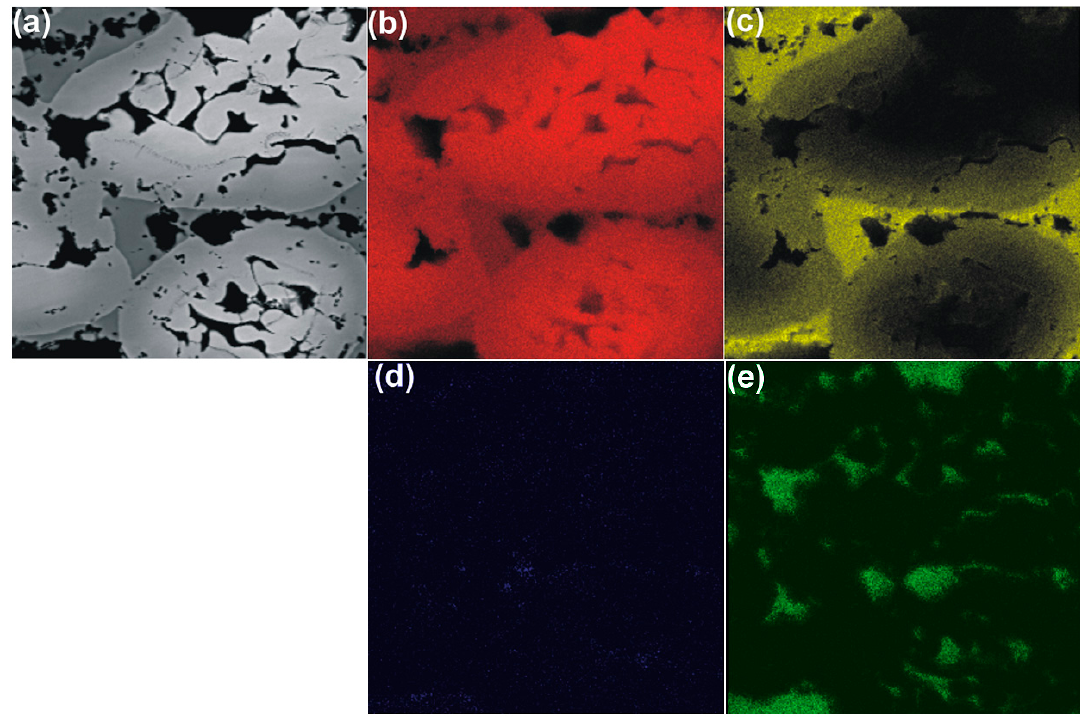
Figure 2. Foams formed via sintering of elemental powders with 5 wt % tartaric acid. ( a ) FE-SEM image; ( b – f ) Elemental mapping: ( b ) iron (in red), ( c ) aluminum (in yellow), ( d ) oxygen (in blue) and ( e ) carbon (in green).